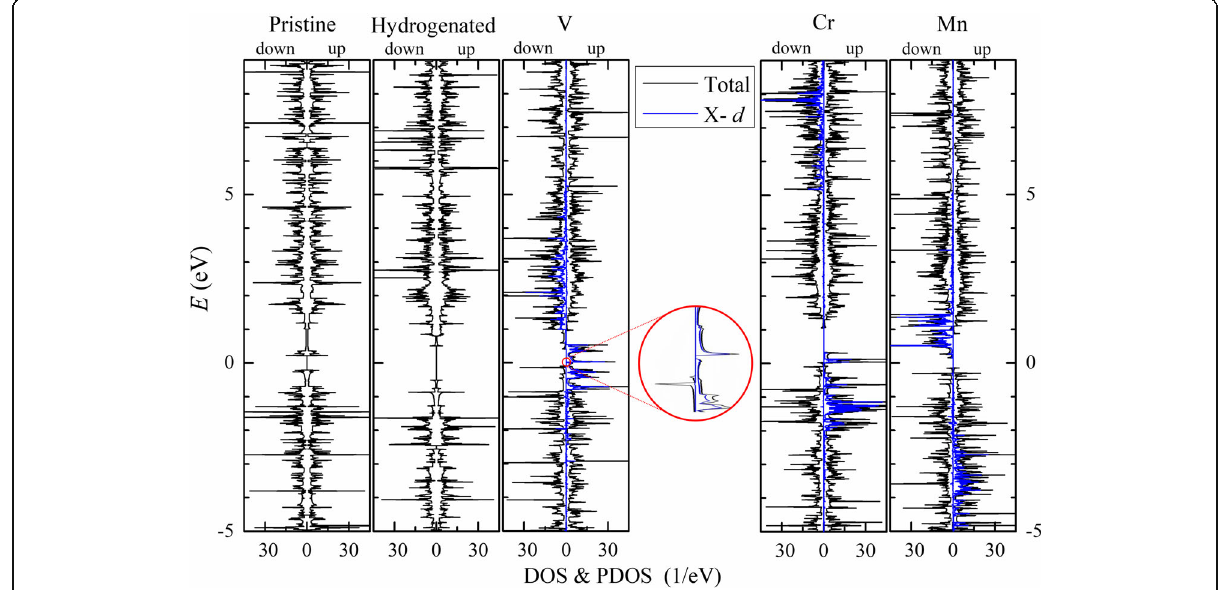
Fig. 5 The DOS (black curve) of pristine and modified 9-APNRs in their FM state is plotted for the up spin (right) and down spin (left). The d orbital PDOS (blue curve) of TM atoms is also presented for comparison. The DOS of V-9-APNR near the Fermi energy is zoomed in the inset to show the band